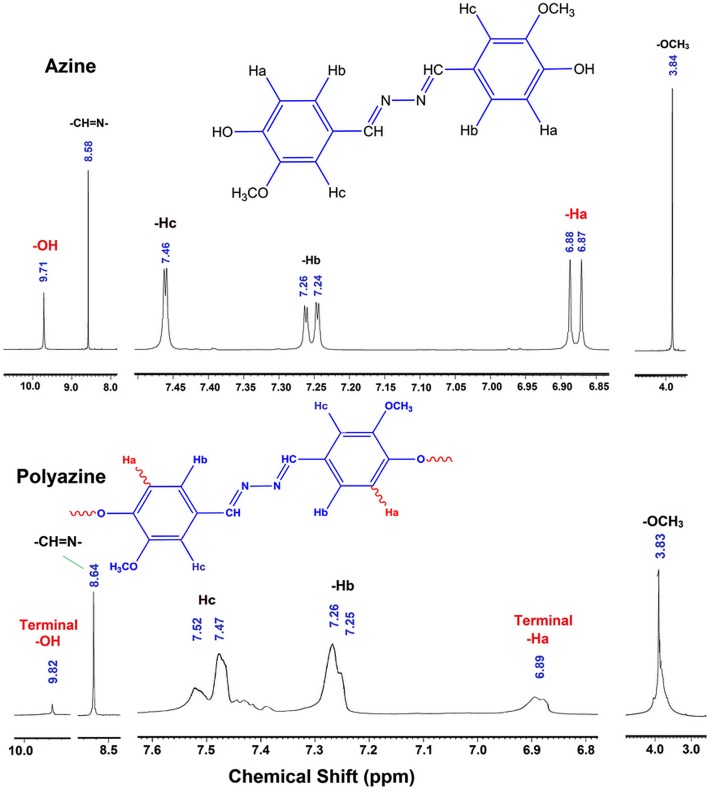

1H-NMR spectra of azine and polyazine.